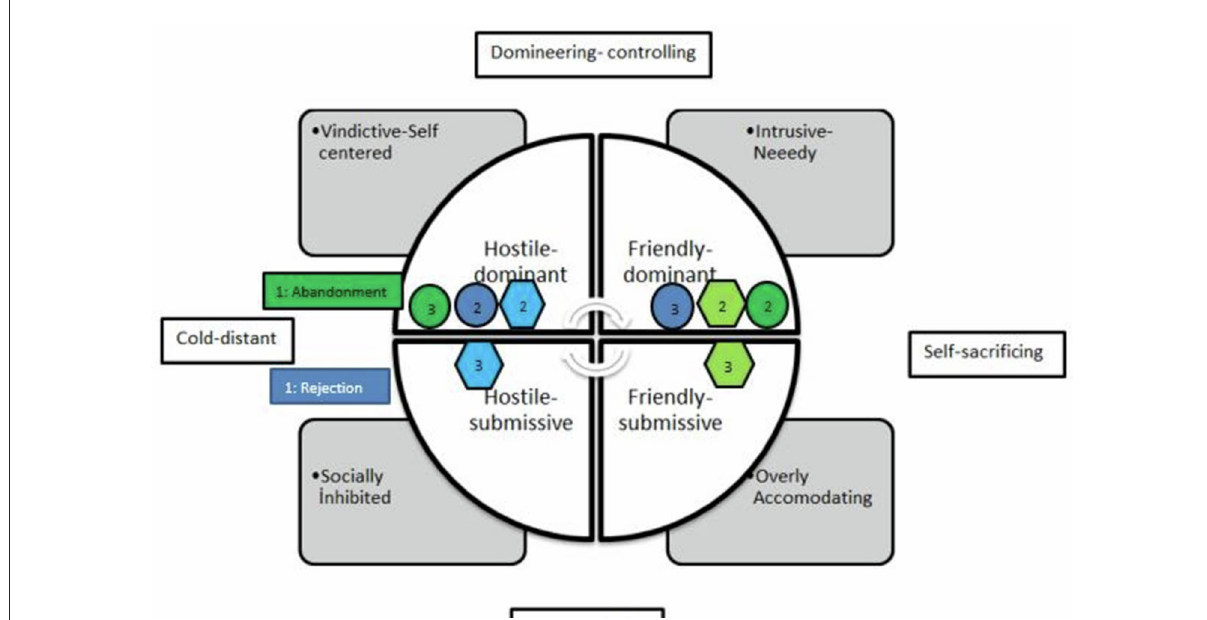
FIGURE2 Participants own and romantic partners reactions according to different groups of narcissism in the Kiesler’s Circle Model (1983). 1: Place of the stories on Kiesler’s circle, 2: own reaction, and 3: expected reaction. Abandonment: Green, Rejection: Blue, Light colors: Vulnerable, Dark colors :